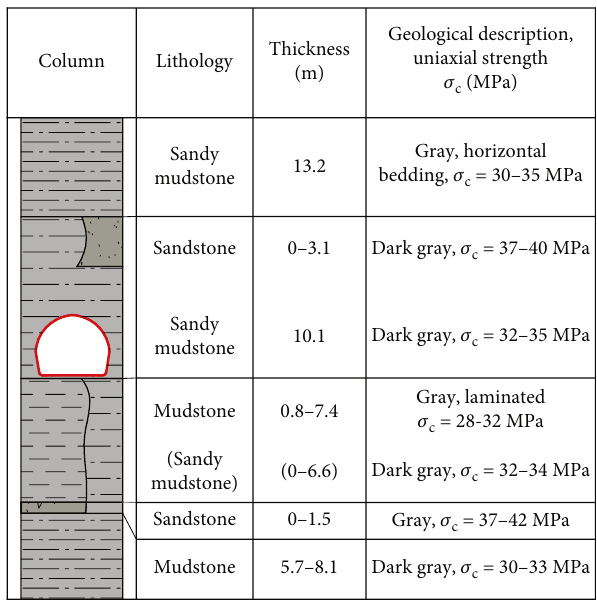
Figure 3: The strata